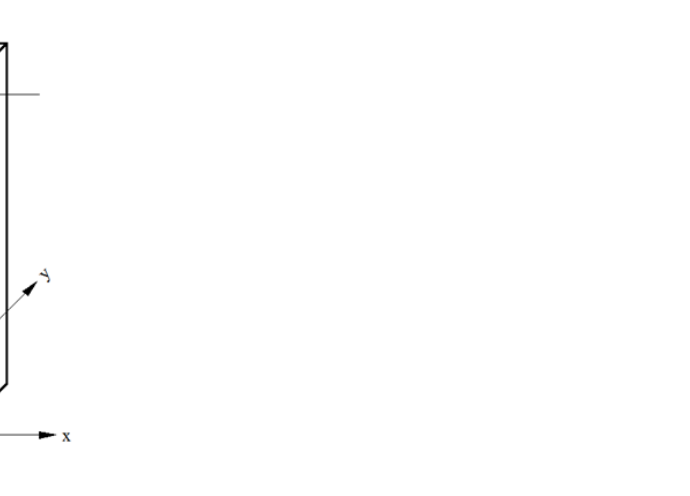
Figure 4. Geometrical and coordinate parameters of the uniform cross-sectioned open thin-walled bar (L: length, S: flexural center, P: pressure, O: section centroid, x and y: principal inertia axes, z: centroidal axis).